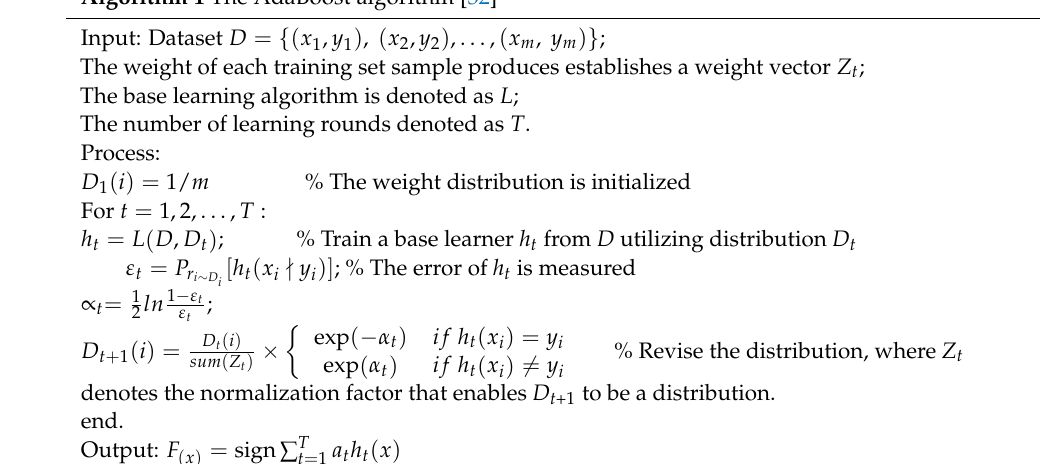
Algorithm 1 The AdaBoost algorithm